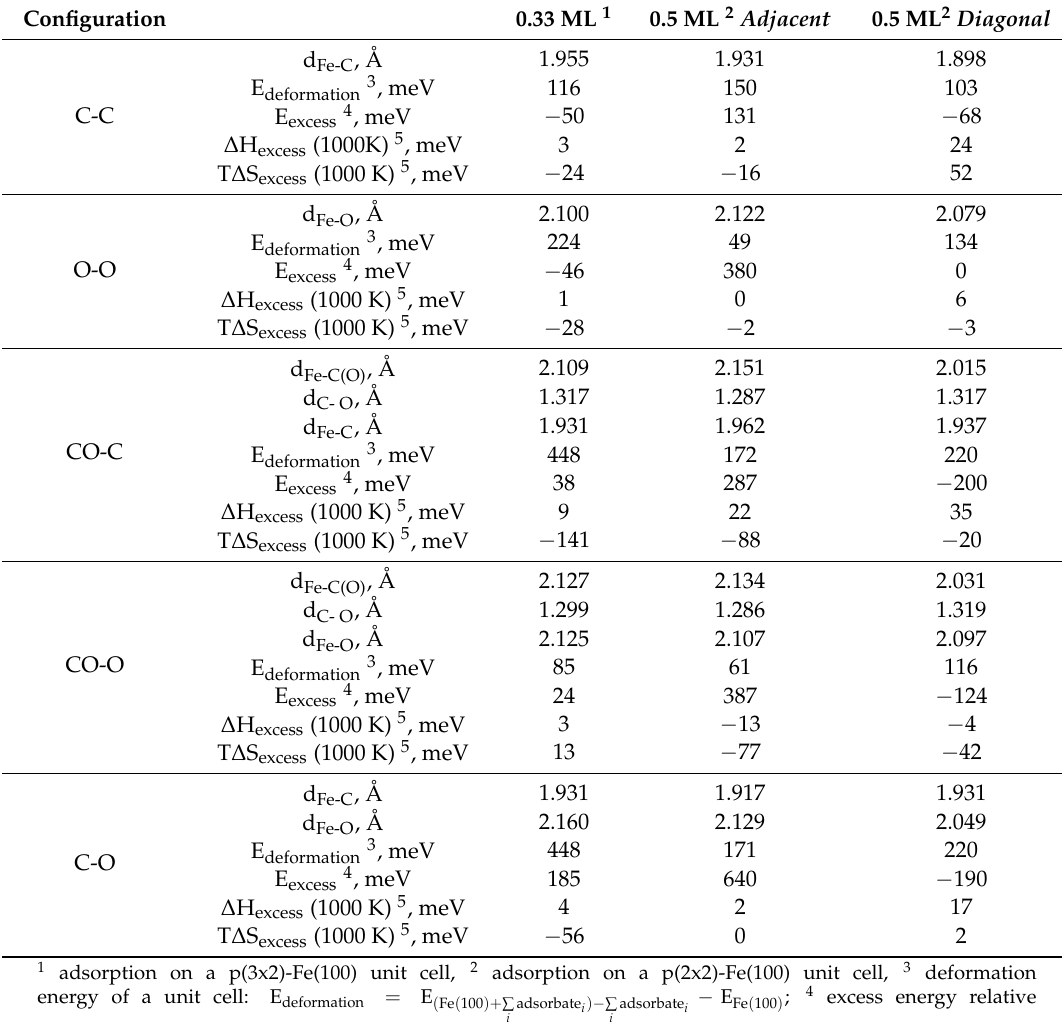
Table 2. Nearest and next-nearest neighbor interactions in the system containing CO, C, and O on